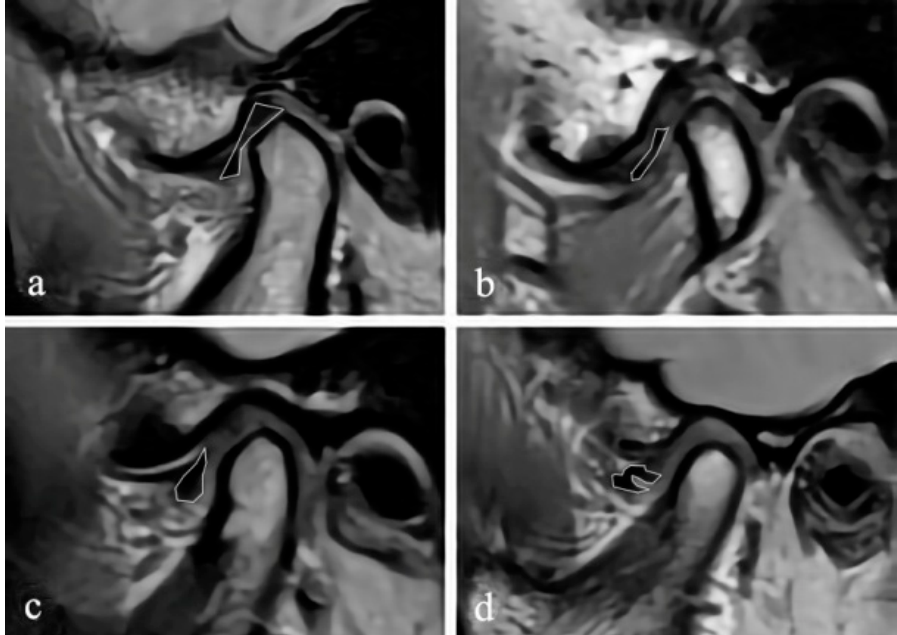
Figure 1. Disc configuration. Oblique sagittal proton density MRI showing the classification of disc configuration: ( a ) biconcave, ( b ) biplanar, ( c ) convex, and ( d ) folded.